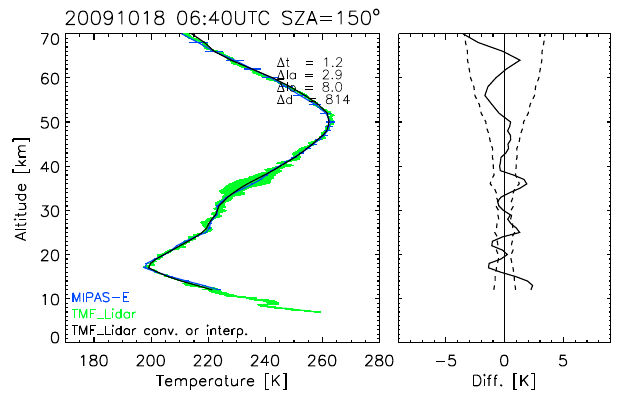
Fig. 1. Left: single MIPAS temperature profile (blue) measured on 18 October 2009 and a coincident profile (within 1000 km, 4 h) of nightly mean TMF lidar measurements (green). The solid black line gives the TMF lidar profile degraded with the MIPAS averag- ing kernel. The blue and green error bars are measurement noise errors of the MIPAS and the correlative measurement, respectively. 1t is the time difference in hours, 1d the spatial difference in kilo- meters, and 1 la and 1 lo are the latitude and longitude differences, respectively, in degrees. Right: the black solid line provides the ab- solute difference between the coincident profiles, while the dashed line is the combined total error (including measurement noise, fur- ther random errors and systematic error components) of the two instruments, both on the coarser grid. For more details, see